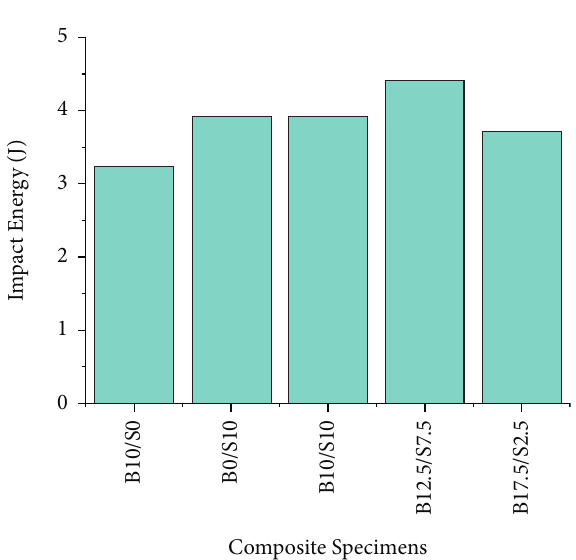
Figure 9: Impact energy of the composite